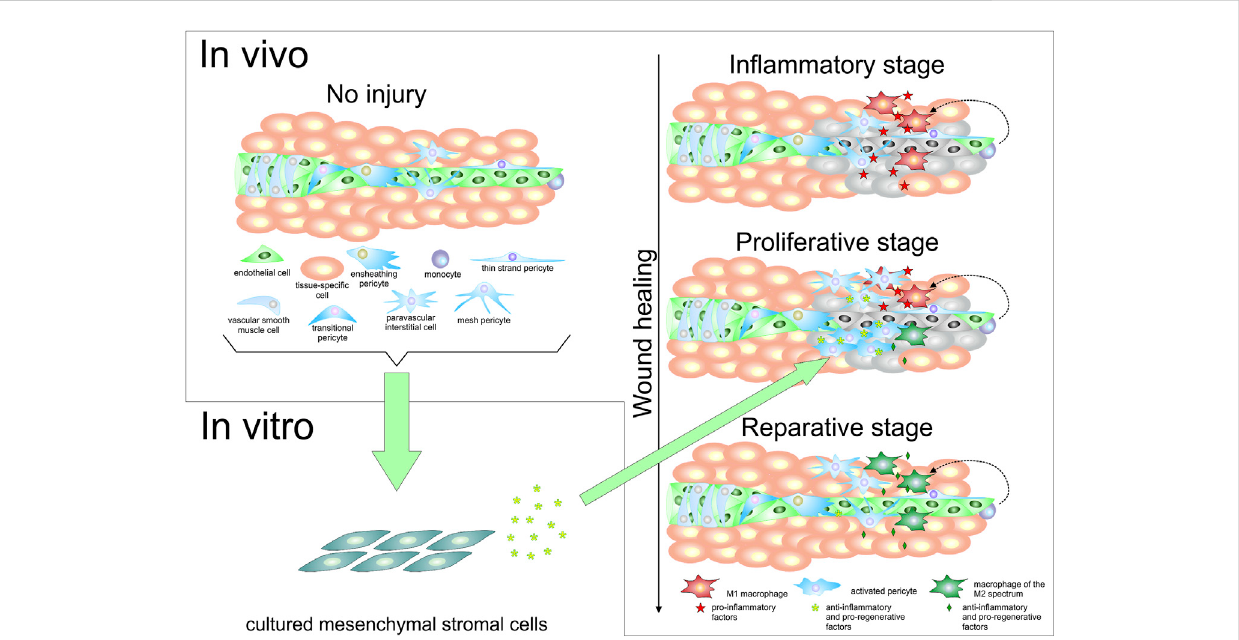
FIGURE 1 Pericytes and mesenchymal stromal cells in vivo and in vitro . The upper left portion of the fi gure shows a schematic representation of a portion of a tissue,whereasmallbloodvesselformedbyendothelialcellsissurroundedbyvascularsmoothmusclecellsatthearteriolelevel,andbydifferenttypesof pericytes, including a transitional form that represents an intermediate between vascular smooth muscle cells and capillary pericytes. A paravascular interstitial cell is also represented, as well as a monocyte, and tissue-speci fi c cells. The lower left portion of this fi gure represents the fact that not only pericytes, but various cell types including some mature tissue-speci fi c cells, endothelial cells, and even monocytes have been found to be able to give rise to cells bearing mesenchymal stromal cell characteristics in culture. The right half of the fi gure schematically depicts the conversion of monocytes into M1 macrophages after a tissue injury event, in the in fl ammatory stage of wound healing (for sake of simpli fi cation, tissue-resident macrophages are not depicted). These M1 macrophages secrete pro-in fl ammatory factors, which lead to pericyte activation and, possibly, paravascular interstitial cell proliferation. In theproliferative stageof wound healing,theprogeny ofperivascular cells secrete molecules that contribute to change the balance between pro-in fl ammatory and pro-regenerative macrophages toward an increase of the latter type, referred to as “ macrophages of the M2 spectrum ” . As these reparative macrophages become more prevalent, they produce increased numbers of anti-in fl ammatory and pro-regenerative molecules. Inthereparative stageofthewound healing process, reparative macrophagescontributeto angiogenesis,whichrestoresbloodsupply tothe tissue; additionally, some of the previously activated pericytes may re-acquire a resting pericyte phenotype to provide physical and functional support to the newly formed blood vessels. Soluble molecules produced by cultured mesenchymal stromal cells (whether in extracellular vesicles or not),